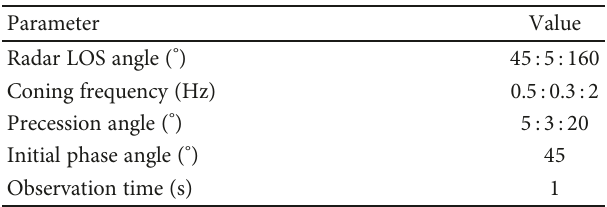
Figure 6: Time-range pro fi les of the three class targets: (a) cone target; (b) cone-cylinder target; (c) cone-cylinder- fl are target. Table 2: Parameter